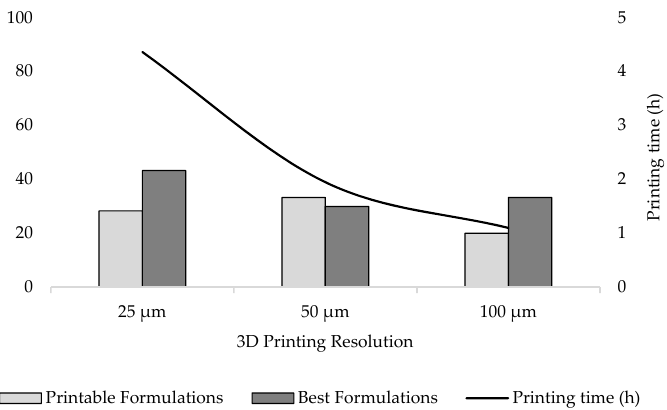
Figure 13. 3D printing resolution effect on printability outcomes. Printable Formulations and Best Formulations are expressed as a percentage of Group B ( n = 60). The black line indicates the printing time required to complete a 12-formulations screening.